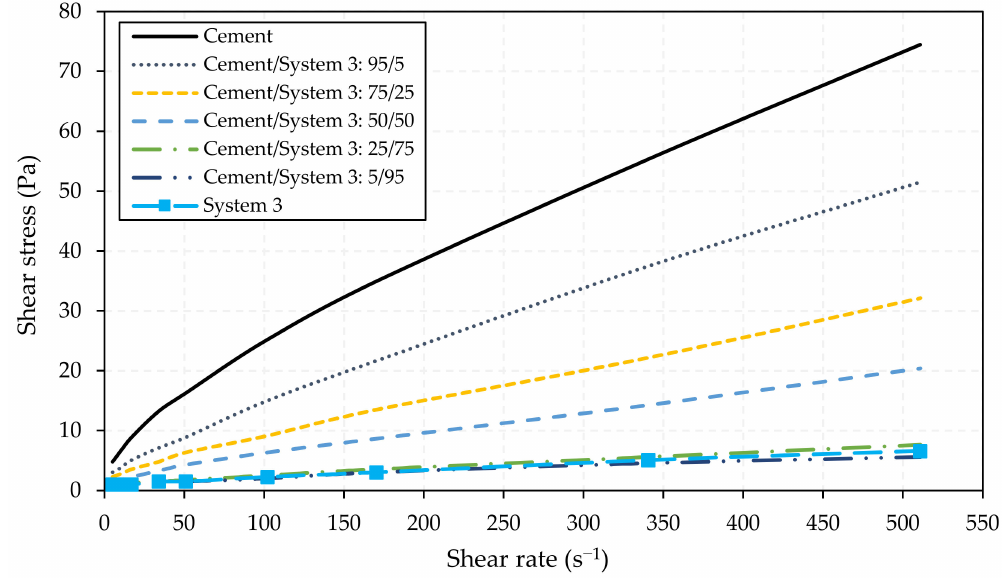
Figure10. Rheologicalbehaviorofcementslurry / cleanupfluidmixture(system3)andpurecomponents.